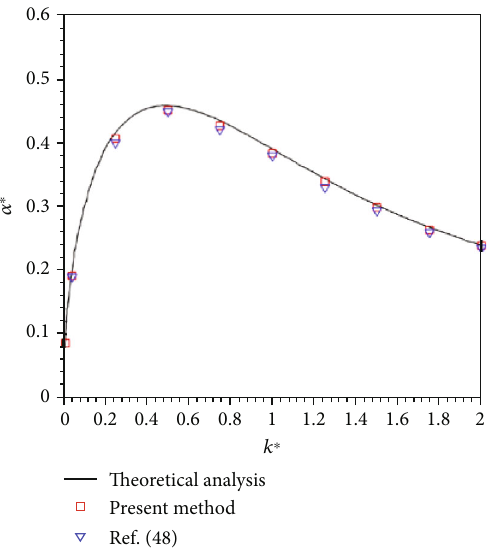
Figure 11: Comparison of the dimensionless growth rate obtained from the numerical methods (symbol) with those predicted by linear theory [47] (solid